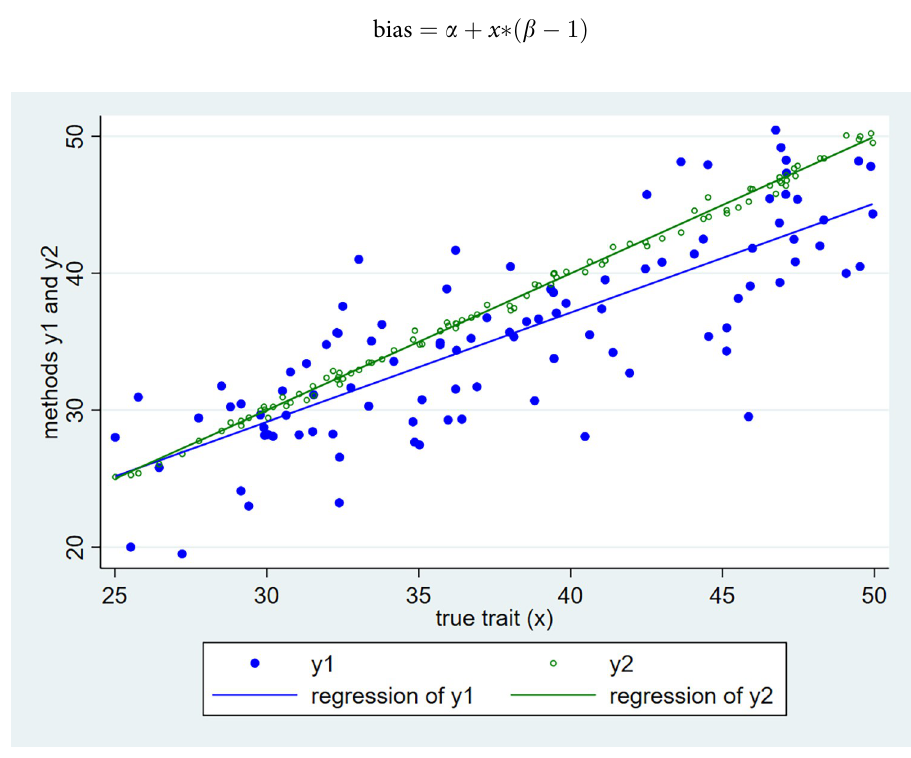
Fig 1. Simulated